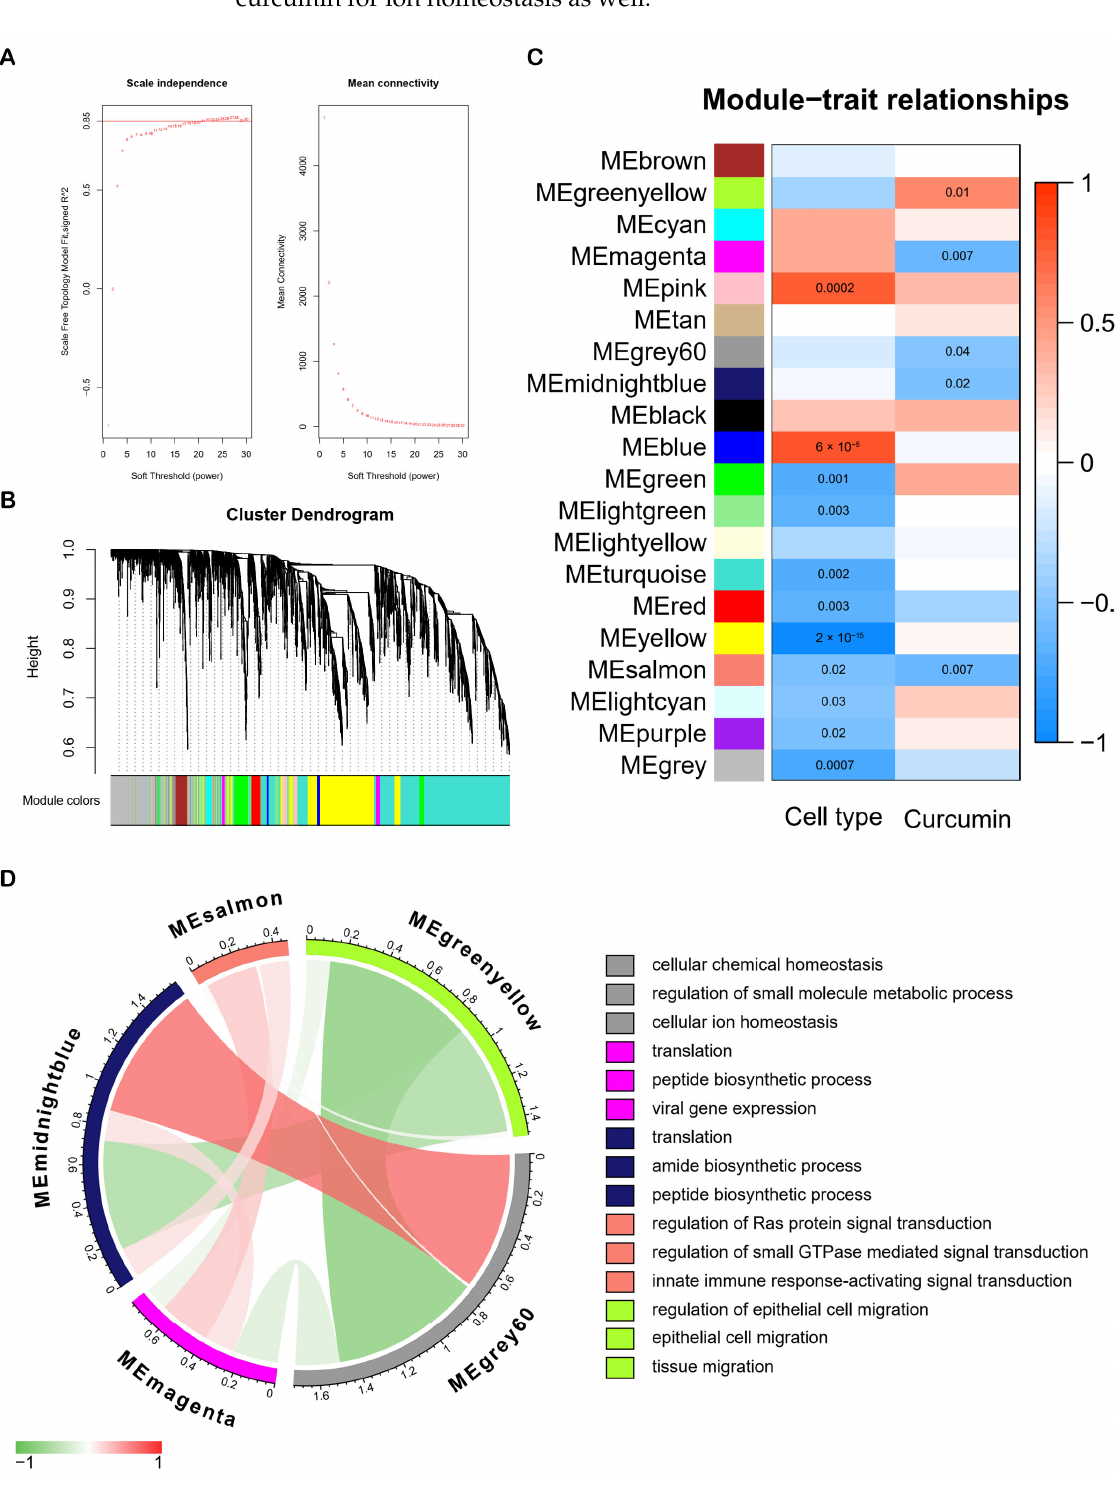
Figure 3. WGCNA analysis and module annotation. ( A ) The soft threshold is set to 21 for WGCNA analysis. ( B ) Twenty modules were constructed through hierarchical clustering. ( C ) The heatmap showed the correlations between modules and traits. ( D ) Correlations among five modules related to curcumin treatment and annotations.